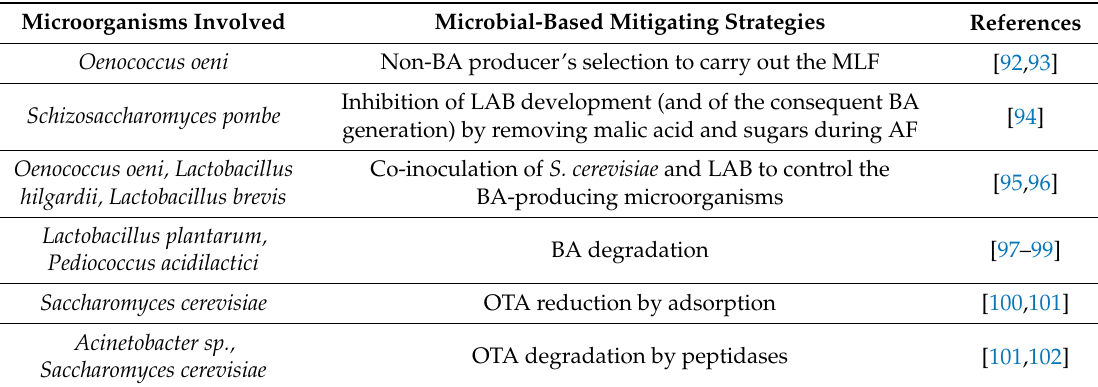
Table 6. A list of studies that propose microbial-based solutions that can have potential applications in mitigating an increased content in mycotoxin and biogenic amines. Microorganisms Involved Microbial-Based Mitigating